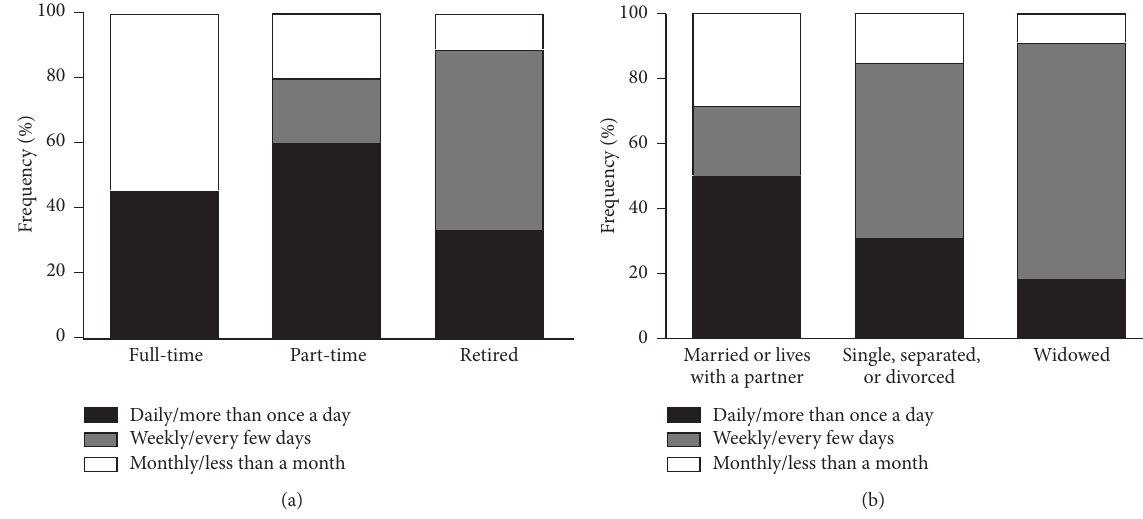
Figure 2: Effect of economic activity (a) and marital status (b) upon the blood sugar screening frequency.